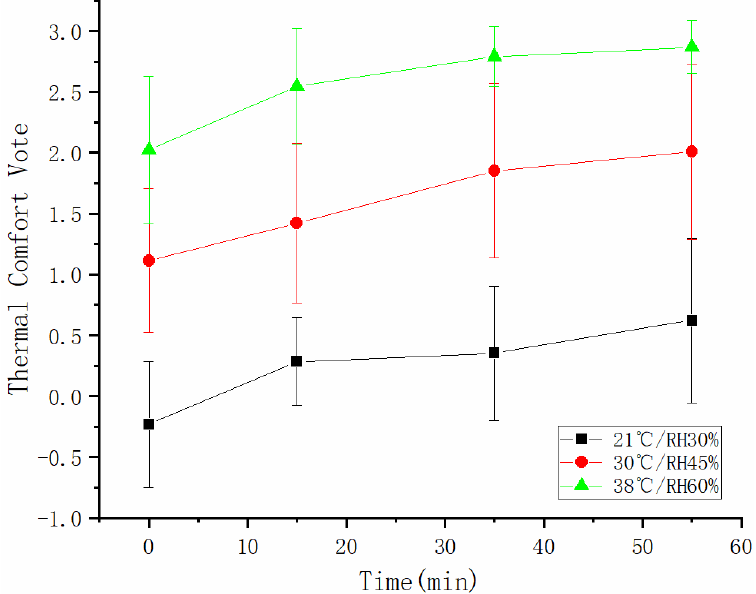
Figure 6. Thermal comfort votes under different environmental conditions.